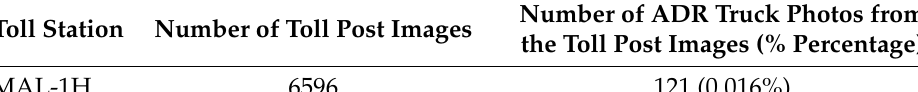
Table 1. dataset used during the ADR-Det validation process, of March 2021, using two toll posts (MAL-1H, MAL-1K)